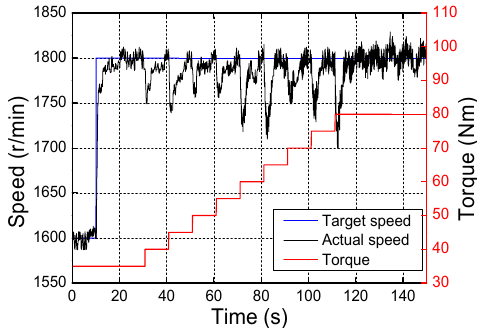
Figure 20. APU torque regulation curve.